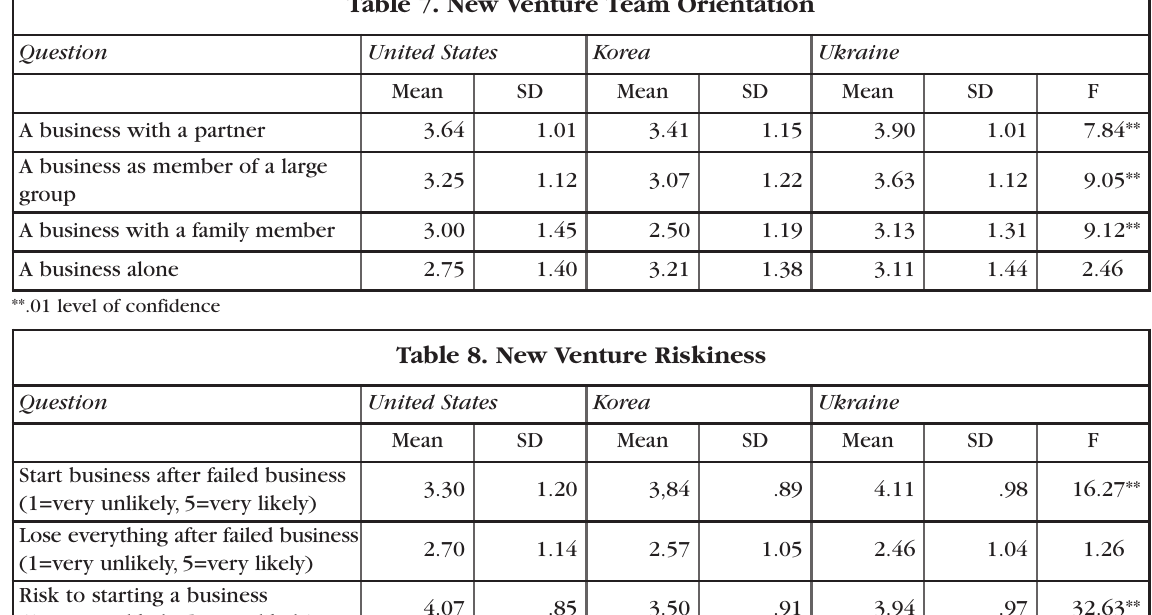
Table 7. New Venture Team